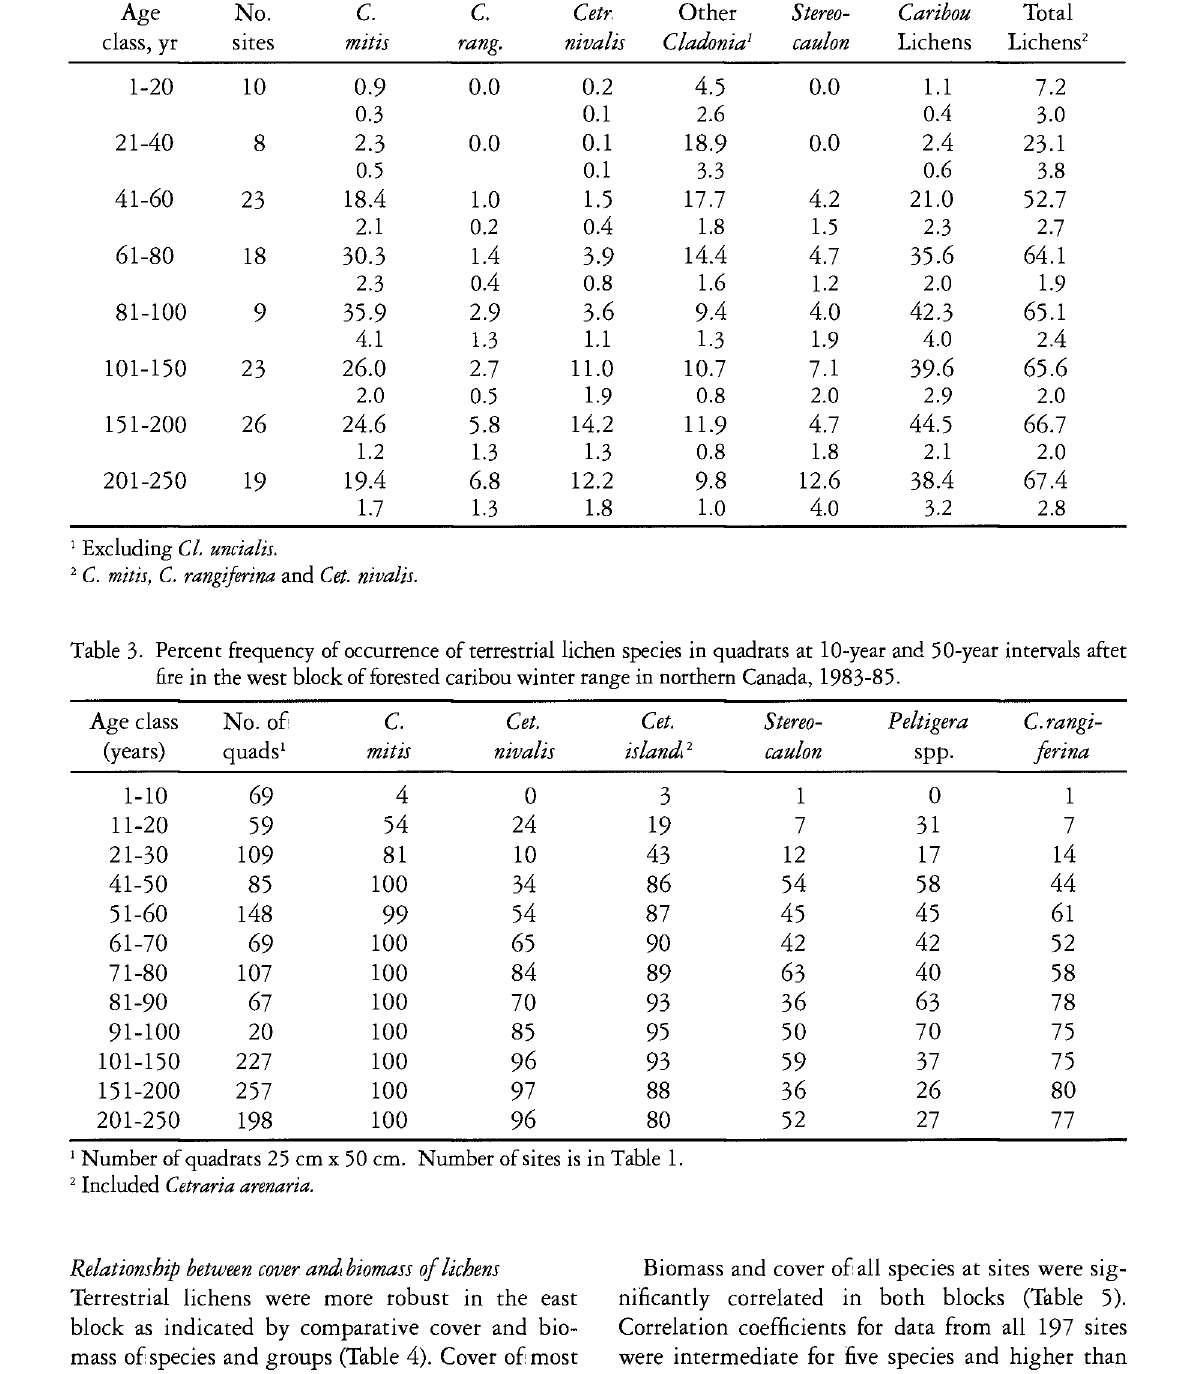
Table 2. Mean percent cover of lichens in eight age classes of foresr sampled in the west block of the winter range of the Beverly herd of caribou, 1983-85. Standatd errors are in smaller print below each mean. Age No. C. C. Cetr. Other Stereo Caribou Total class, yr sites mitis rang. nivalis Cladonia 1 caulon Lichens Lichens 2